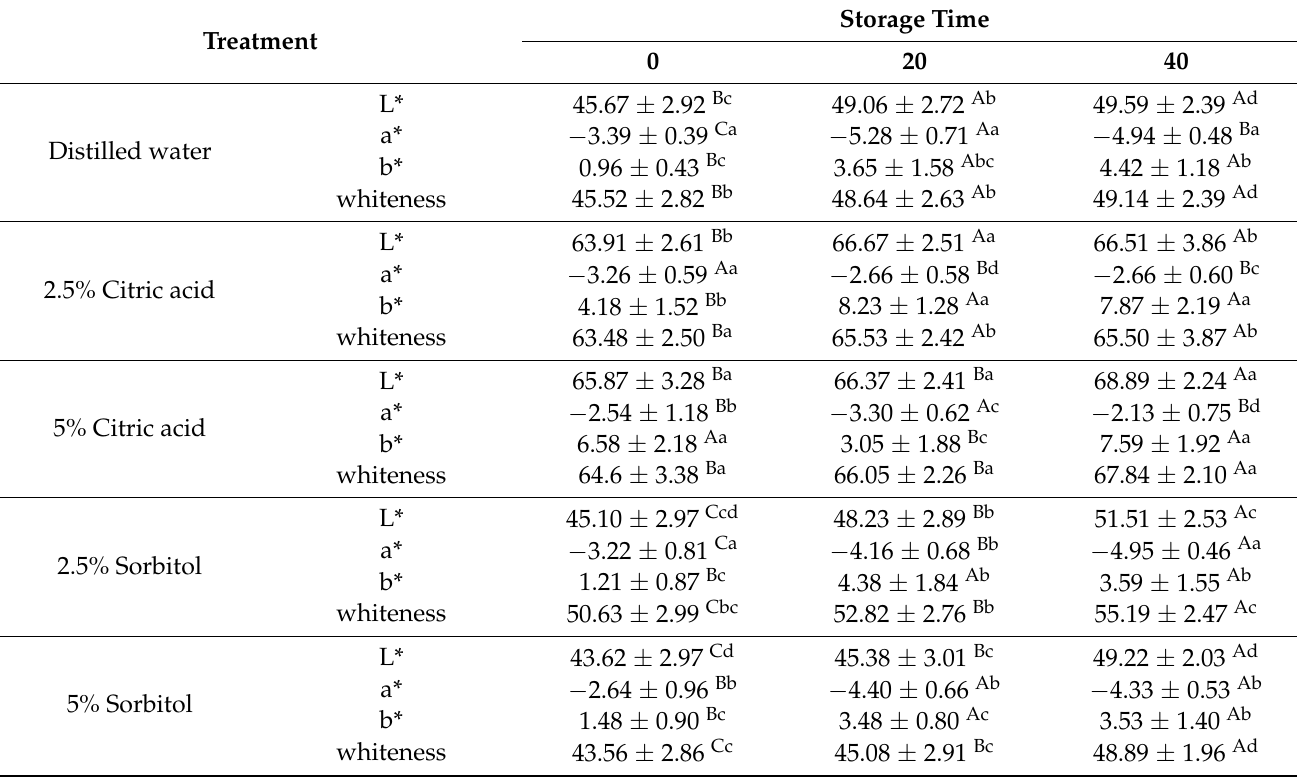
represented an increase in yellowness and redness of frozen fish fillets, respectively. The L* and b* values increased significantly after 20 and 40 days of storage, but a* showed slightly changes during storage. During freezing, the yellow color of fish fillets was increased, and red color was increased at the posterior end of the fillets, causing a visible change in appearance (Figure 3). All samples became less red due to the reduced freshness and greyer appearance compared to day 0. An increase in L* value indicated the development of lipid oxidation during storage time, leading to a brighter fillet [36]. Frozen fish fillets soaked with citric acid solution demonstrated effectively increased whiteness (L*) and yellowness (b*) compared to the other samples during storage. The color values of fish fillets soaked with sorbitol solution were similar to the samples soaked with distilled water. Table 4. Color measurements of frozen fish fillets soaked with different solutions after thawing during frozen storage